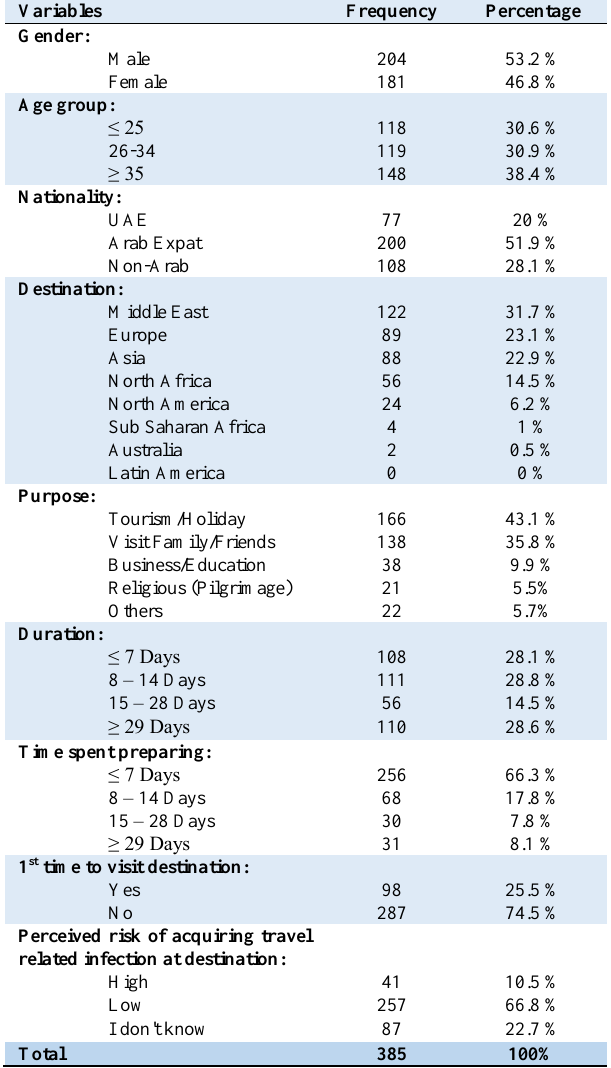
Table 1. Variables associated with pretravel health advice practices and